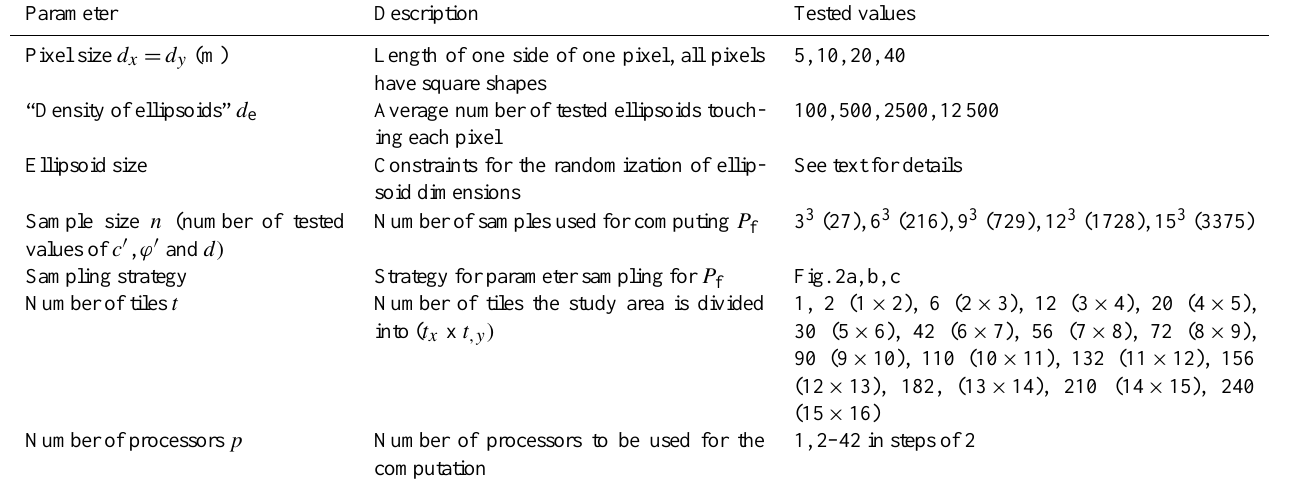
Number of processors to be used for